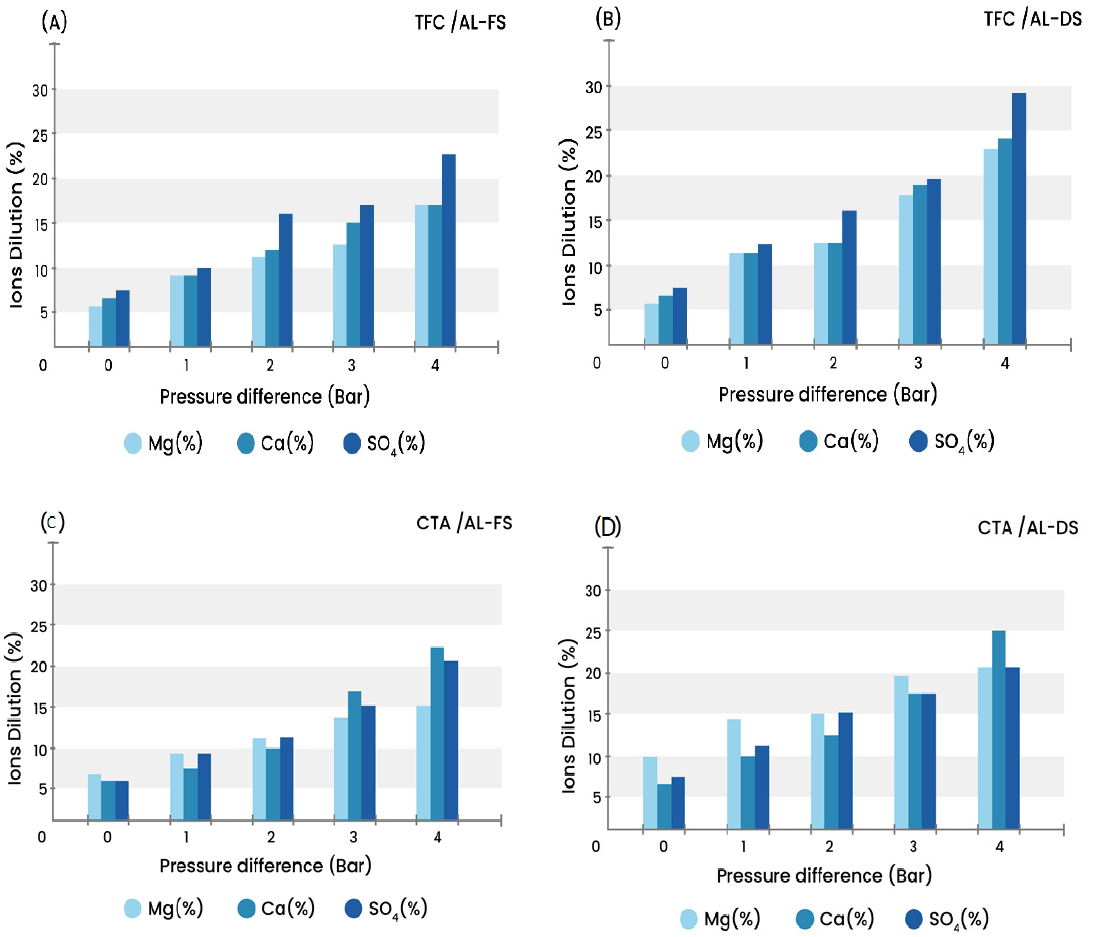
Figure 10. Mg 2+ , Ca 2+ , and SO 42 − dilution in the DS following FO process at different applied pressures and in FO and PAFO mode using TFC and CTA FO membranes. ( A , B ) TFC membrane in AL-FS and AL-DS orientations, respectively. ( C , D ) CTA membrane in AL-FS and AL-DS orientations, respectively.